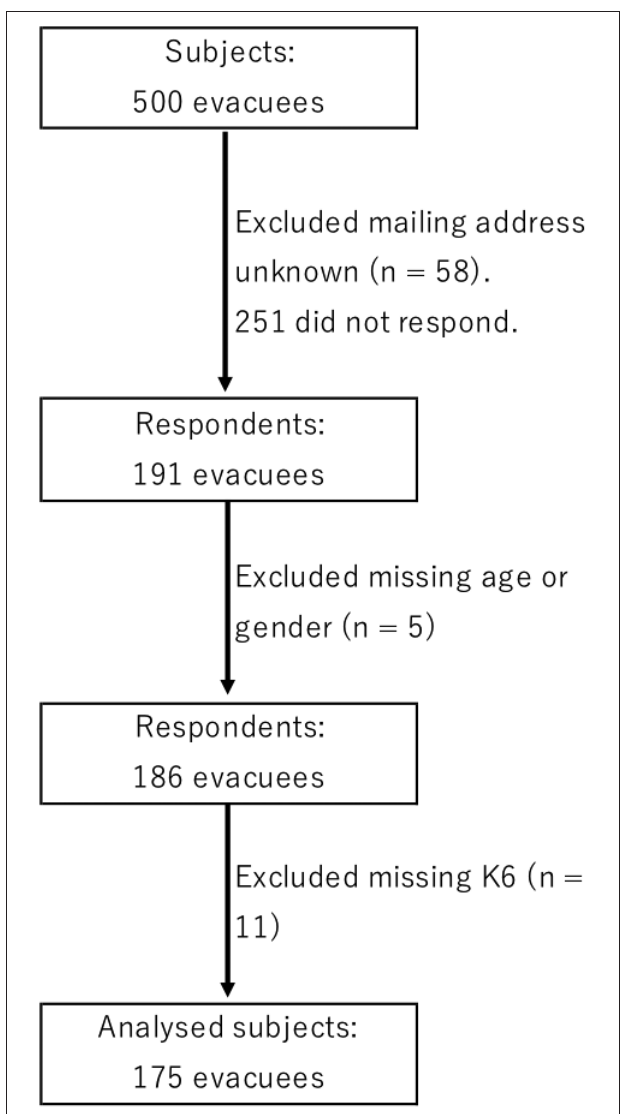
FIGURE 1 | Flow chart of study procedures. From the targeted population ( n = 500), 58 were excluded due to mailing address unknown. Two hundred fifty-one did not respond. Final number of valid responses was 175 after excluding respondents with missing data regarding age, gender or the 6-item Kessler psychological distress scale